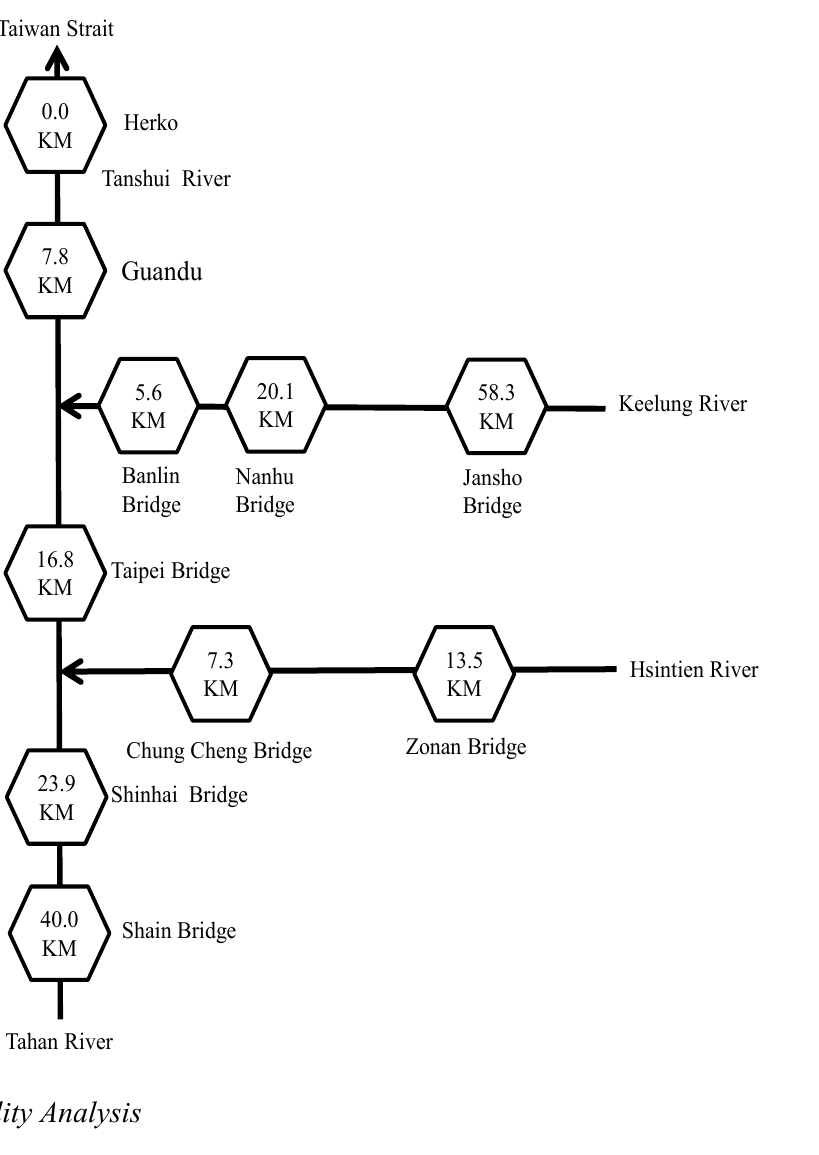
Figure 5. Distances in river kilometers of sampling stations in the catchment of the Tanshui